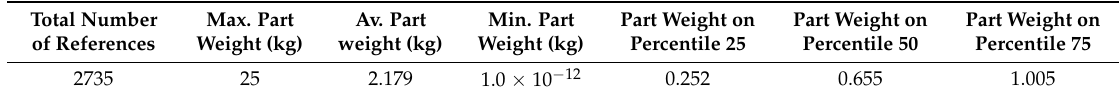
Table 3. Distribution of the mass in the product